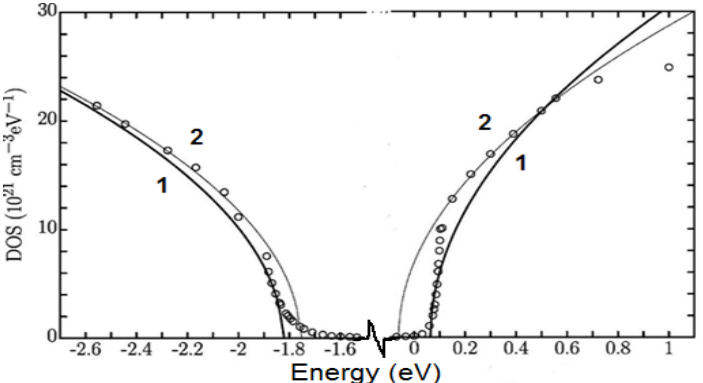
Fig. 1: Malik and O'Leary re-analysis DOS distribution data for a-Si: H